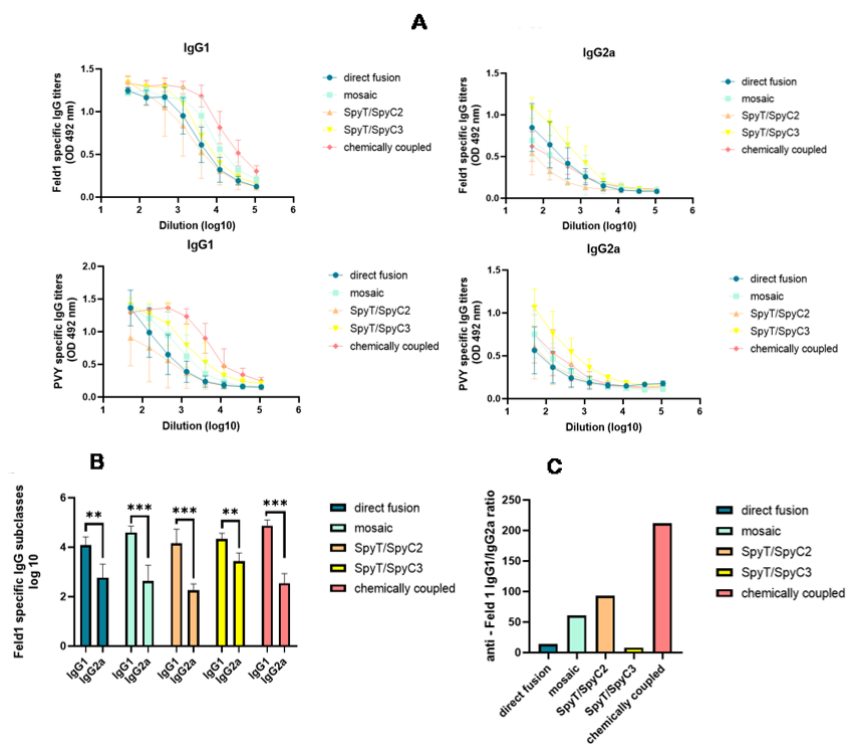
Figure 9. PVY–Fel d 1 variants induce subclass switching by ELISA analysis. ( A )—Anti–Fel d 1- and anti-PVY CP-specific IgG1 and IgG2a titers measured in Day 42 mouse sera at OD492 nm. ELISA plates were coated with PVY–Fel d 1 variants to detect IgG subclasses in mice vaccinated with PVY–Fel d 1 variants. ( B )—Log 10 values of Feld1-specific IgG1 and IgG2a titers measured in Day 42 mouse sera; ( C )—anti-Fel d 1 IgG1/IgG2a ratio measured from titers used in the experiment shown in ( B ); ( A , B ) Statistical analysis using Student’s t test in GraphPad Prism 9.0. Vaccine groups n = 5. One representative experiment is shown. A value of p > 0.05 was considered statistically significant (** p < 0.001; *** p